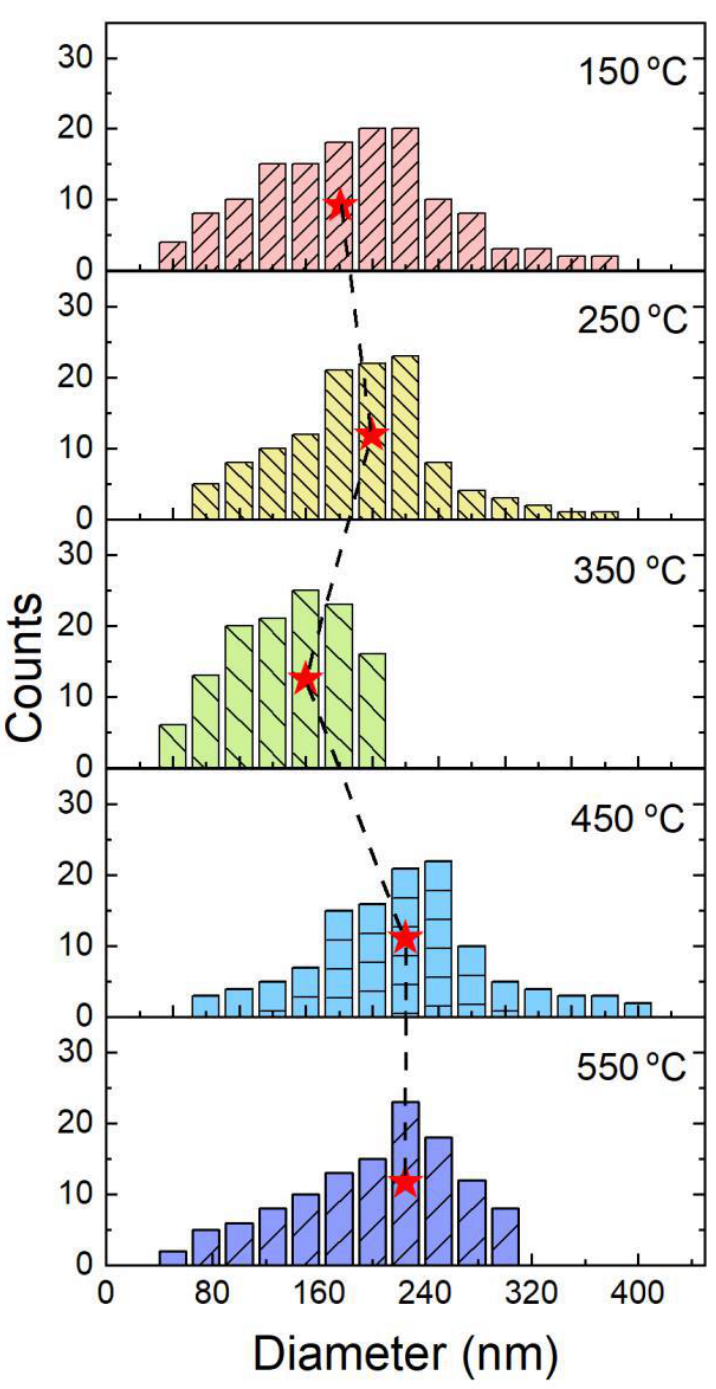
Figure 7. Statistical histograms of diameter sizes for OsO 2 nanospheres at 150–550 ◦ C, 100 MPa, and 24 h in the 0.005 mol/L initial solution. Note that the asterisk represents the median of counts of different temperatures.